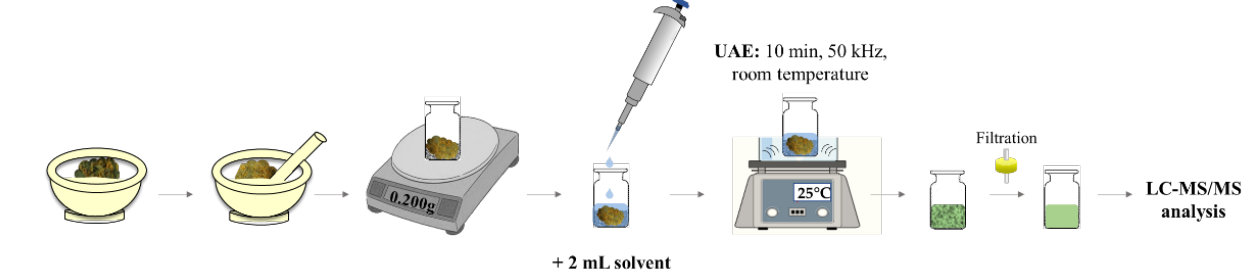
Figure 2 . Schematic representation of the UAE experimental procedure. Figure 2. Schematic representation of the UAE experimental